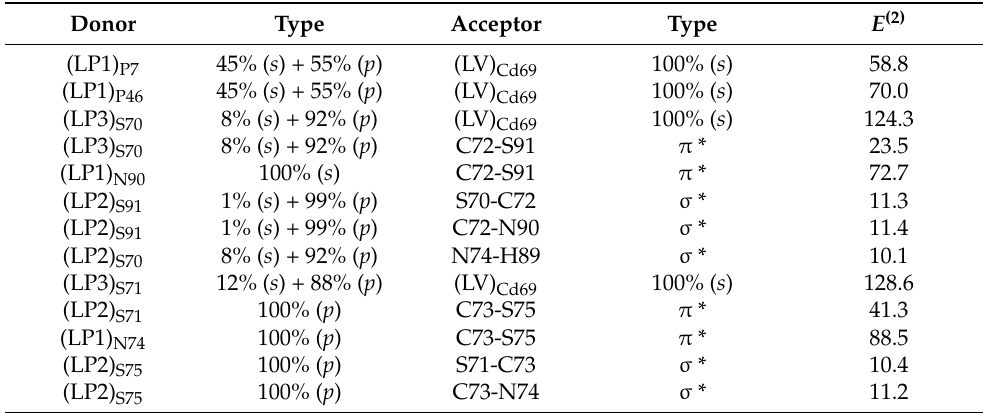
Table 7. Second order perturbation energies for charge transfers from donor to acceptor orbitals in Cd(7)